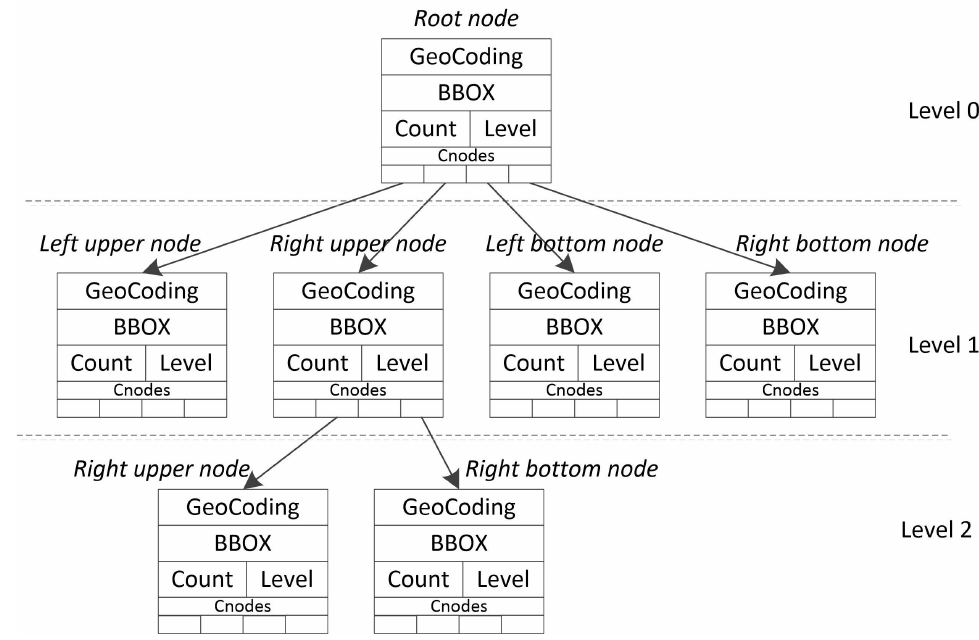
Figure 2. Structure of viewport pixel